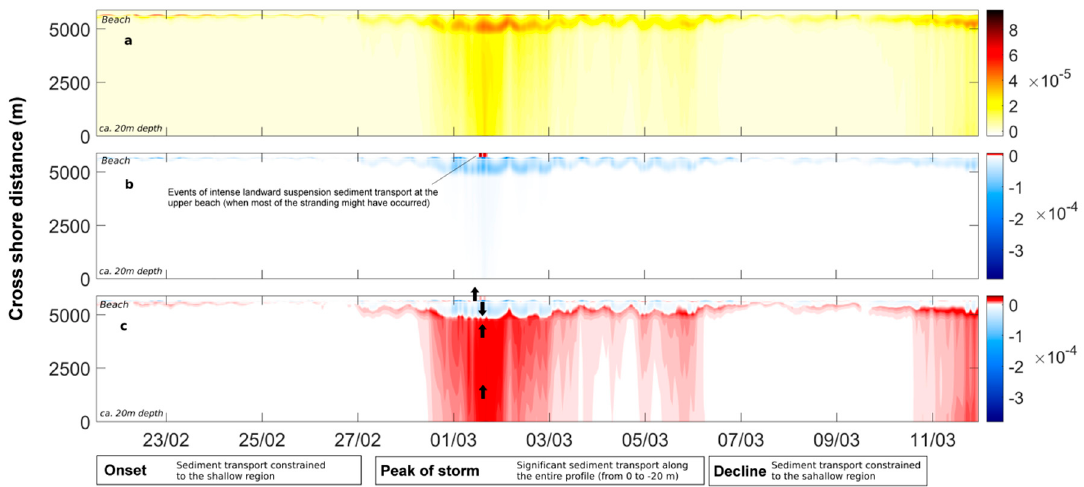
Figure 8. Transport of sediments according to the model: ( a ) Bed load, ( b ) suspended load and ( c ) total load (combined bed and suspended load). Arrows on panel ( c ) show the net direction of sediment transport during the peak of the storm (arrows up indicate transport towards the beach, whereas, arrow down indicates transport towards the open sea).